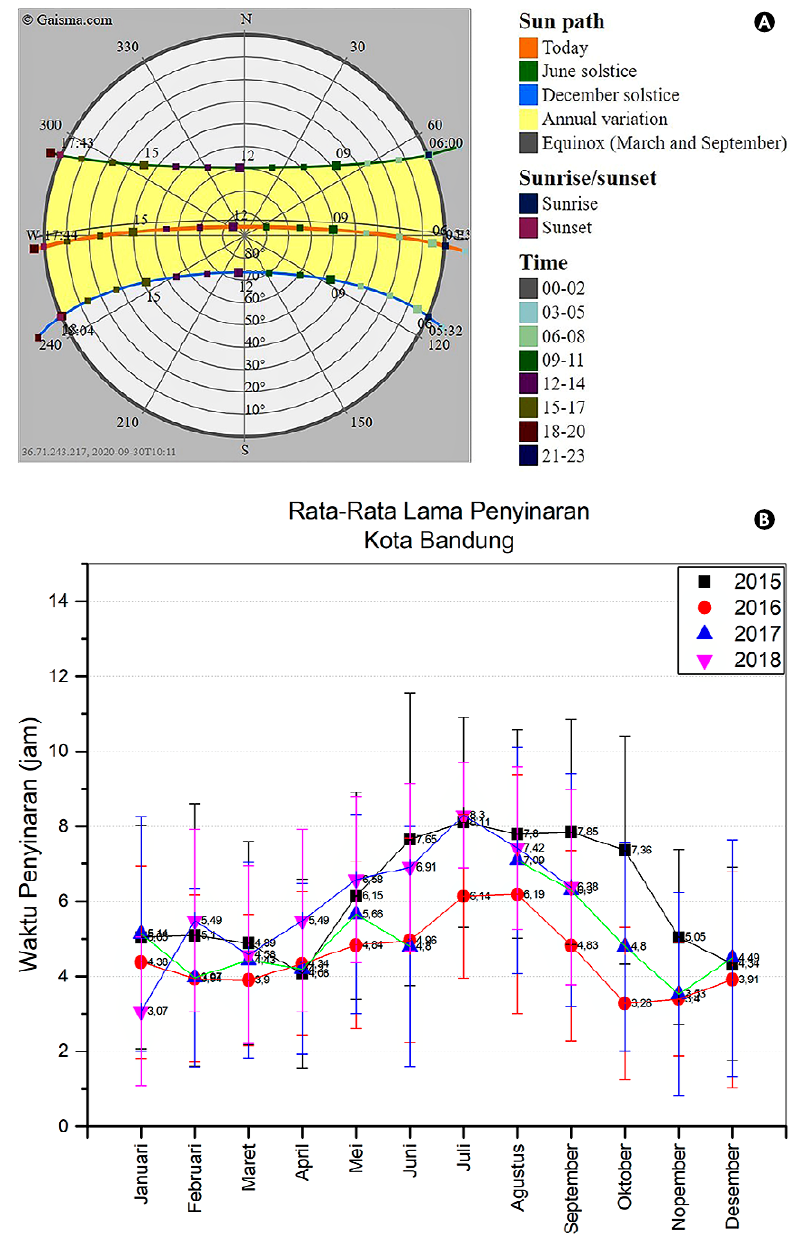
Figure 2. (a) Sun path diagram and (b) sunshine of Bandung Source : (a) Gaisma (2020) and (b) Kusyanto et al.